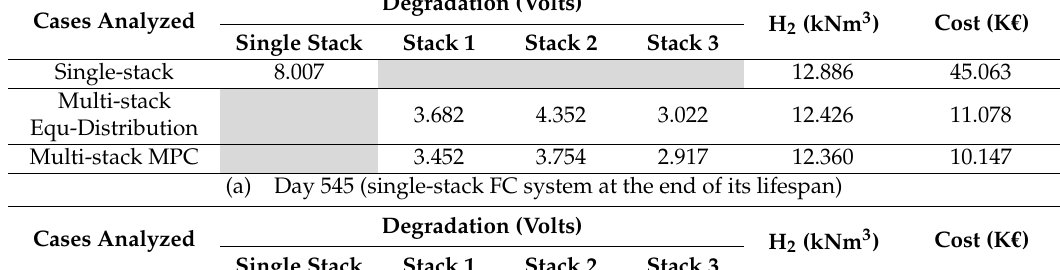
Table 5. Simulation results.